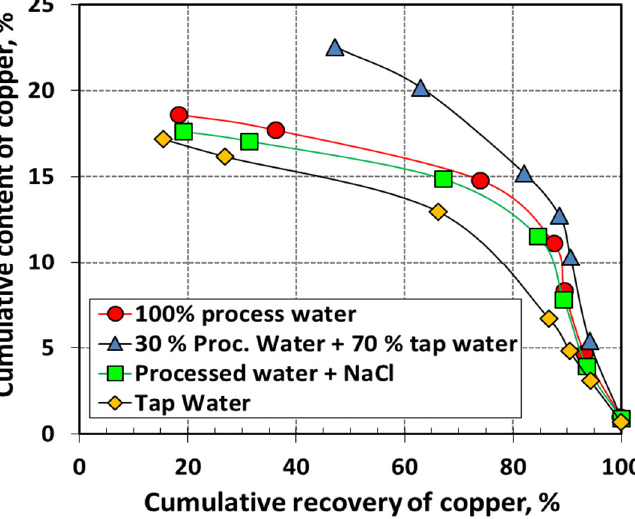
Figure 18. Result of the copper ore flotation response in different water types [145].